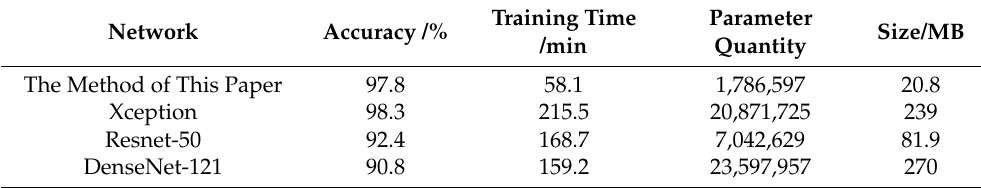
Table 8. Comparison between Different Methods.